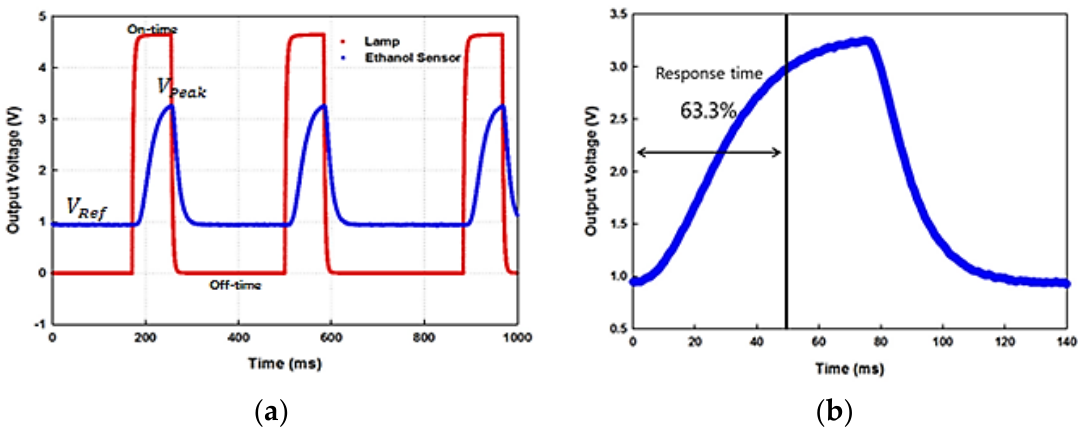
8 of 14 Figure 6. Block diagram of experimental setup. MFC: Mass Flow Controller; DUT: Device Under Test. A multi-gas analyzer (INNOVA-1312, LumaSense Technologies A/S, Ballerup, Denmark) was used to standardize the successive measurements of ethanol concentration with a precision of 1 ppm or less. The gas analyzer is calibrated and attached with special filters for accurate ethanol measurement. The connection from the analyzer to the gas chamber is properly insulated. The output of the sensor module according to the concentration was recorded as a voltage in the computer, and the corresponding experimental data was saved using the RS-485 communication. 5. Result & Discussion 5.1. On-Off and Response Time The IR source is modulated for pulse generation and recorded on-off time is shown in Figure 7a. The optimum on-off time of IR source is found to be 100 ms and 300 ms, respectively. The values were chosen after iterative experiments. It takes a while for the source to transmit IR energy to the detector, so that the sensor response can reach to the peak amplitude level but even